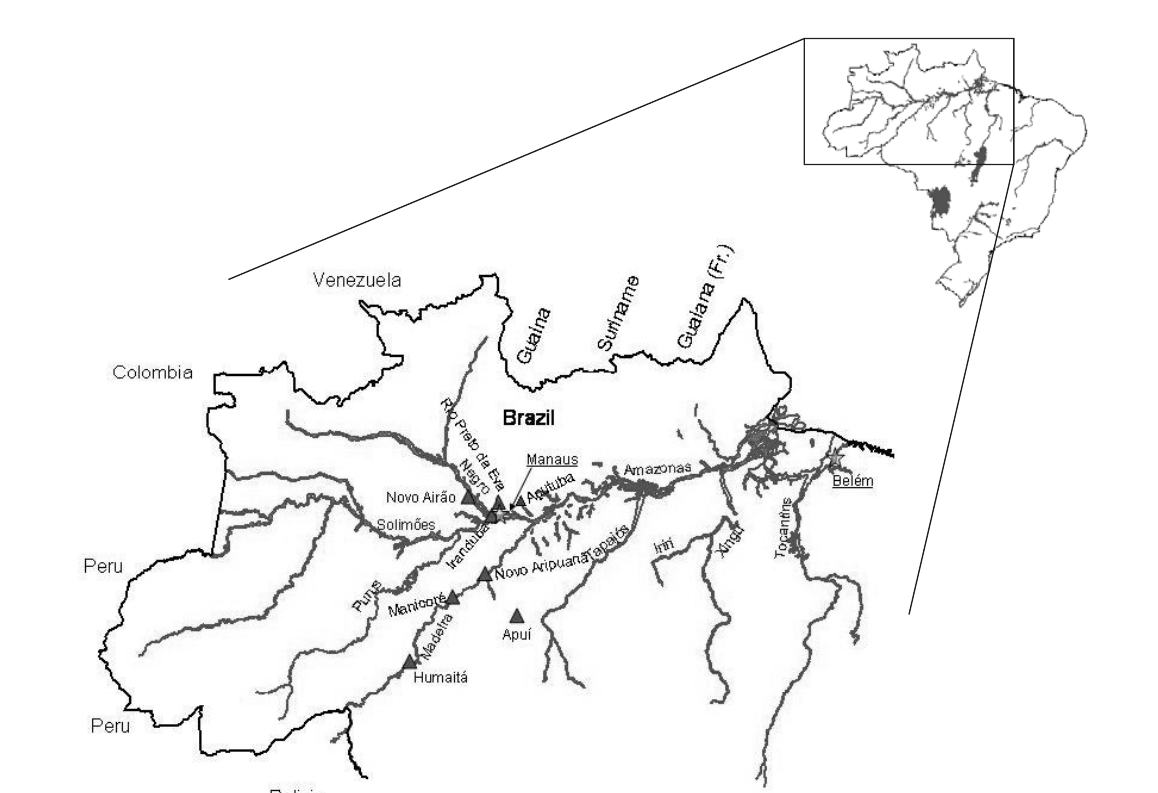
Figure 1. Localization of the areas where soil samples were collected. Triangles indicate administrative centers of